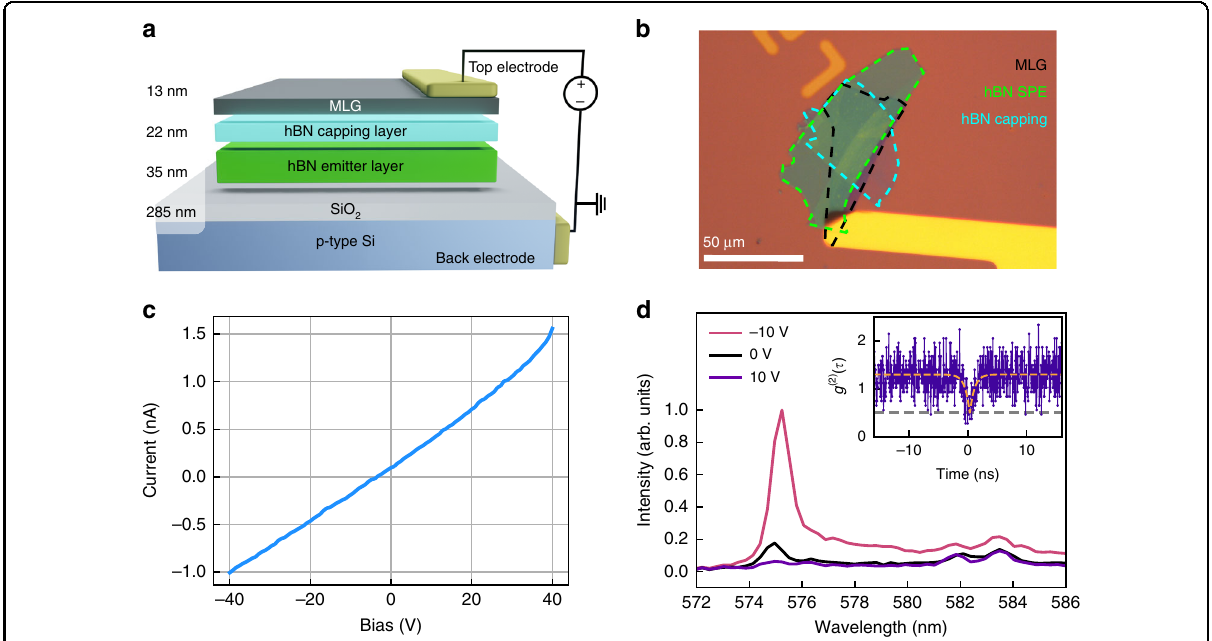
Fig. 1 The hBN/MLG heterostructure device. a Schematic of the device and its operating principle. The device is biased using gold electrodes in contact with MLG and p-type silicon. Layer thicknesses are indicated on the left. b Optical image of a device consisting of MLG, an hBN capping layer, and an hBN layer that contains SPEs. The substrate is bulk p-type silicon with a 285 nm thermal oxide layer. Each layer is outlined by dashed lines. c I – V curve from the device shows a negligible leakage current. d Normalized PL spectra of a fl uorescence peak at 575 nm from the heterostructure under a bias of − 10 V (red), 0 V (black), and 10 V (violet), at 4 K. Inset: Second-order correlation data measured from the same emitter under − 10 V bias, at 4 K. The PL was fi ltered using a tunable bandpass fi lter centered at 575 ± 2 nm and the fi t (dashed yellow) reveals g (2) (0) = 0.48. The g (2) (t) model and analysis are developed further in the supplementary